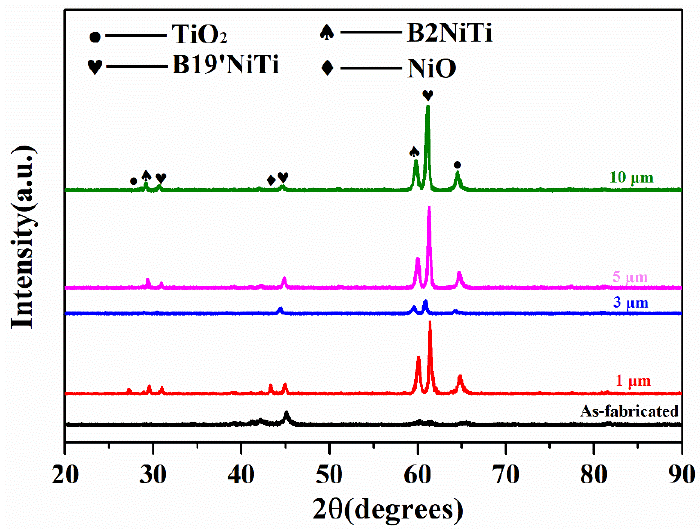
Figure 3. XRD patterns of different samples processed by femtosecond laser shock peening.